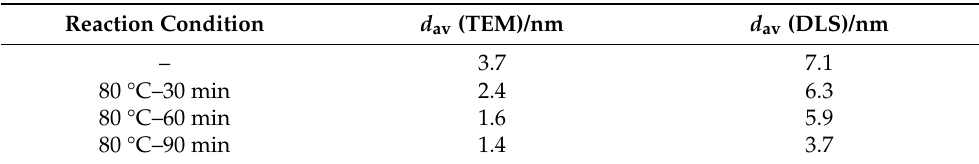
Table 3. The average particle size of colloidal nanoparticles in the reaction mixture for preparing Pt nanoclusters measured by TEM and DLS. Reproduced with permission, Copyright 2020 Editorial Office of Acta Physico-Chimica Sinica [102].